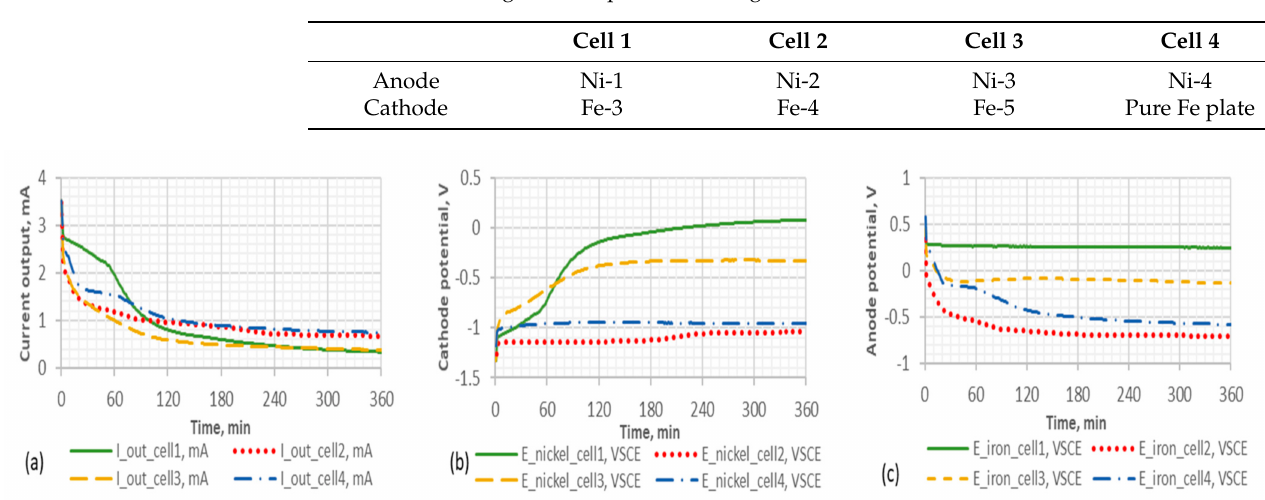
Table 10. Cell arrangement of powder-mixing electrodes.